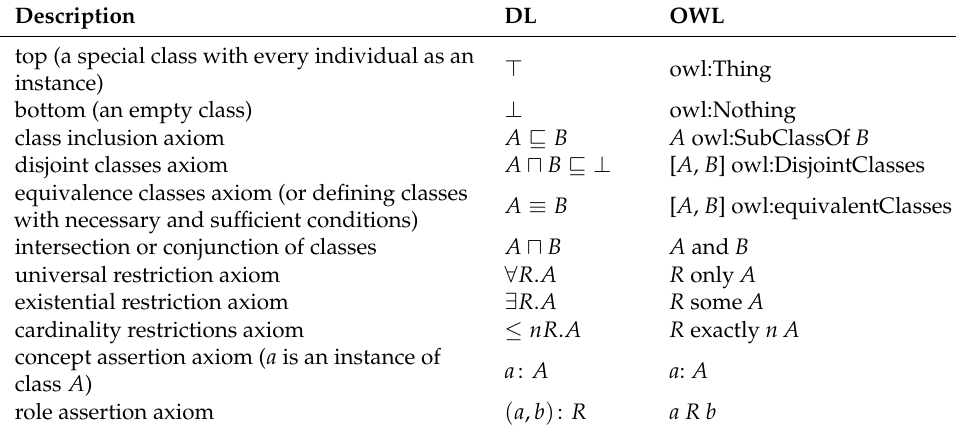
Table 1. DL operators and